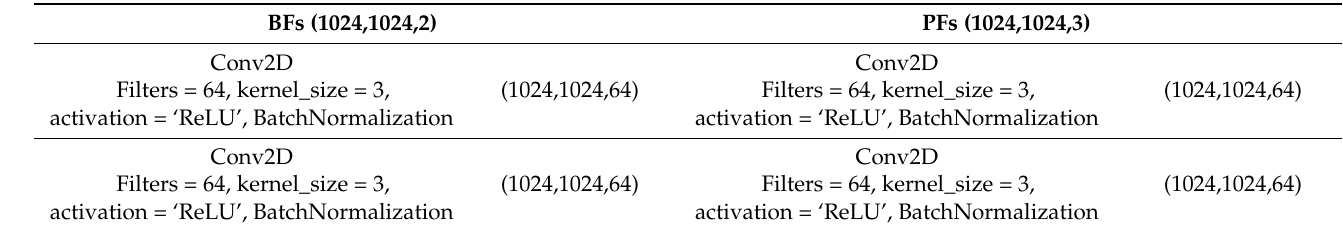
Table 4. Parameters of